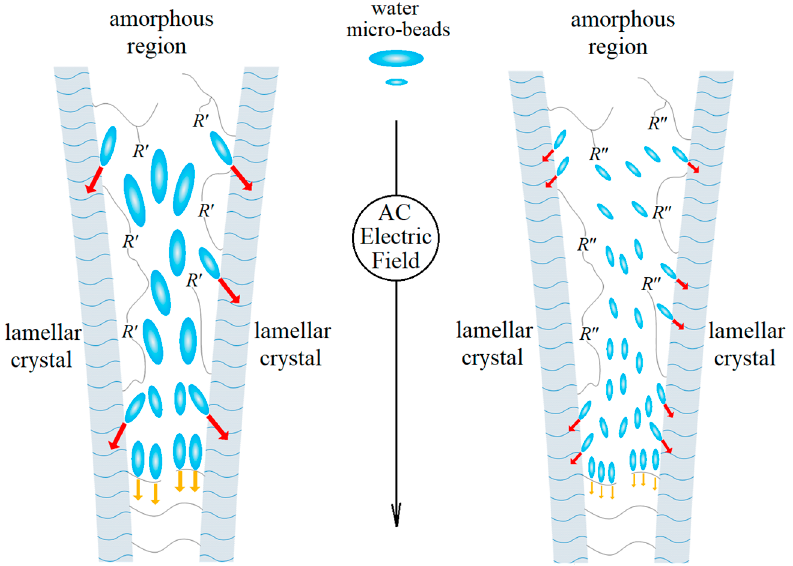
Figure 8. Schematic electromechanical mechanism of water micro-droplets breaking through the amorphous regions in XLPE-g-CAAE ( left panel ) and XLPE-g-MAH ( right panel ).